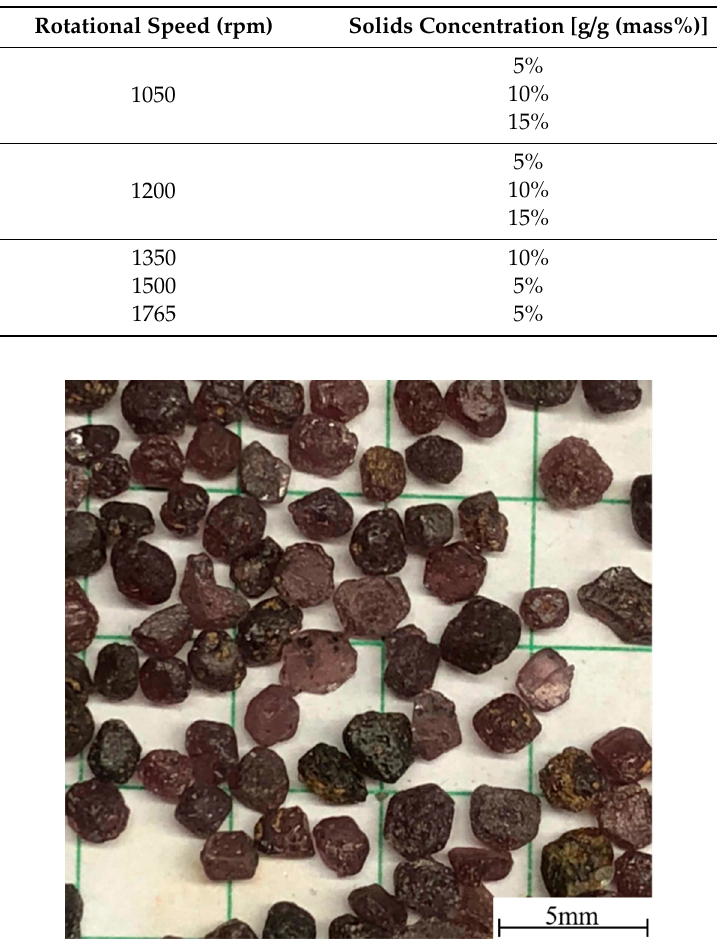
Table 1. Wear tests conditions.